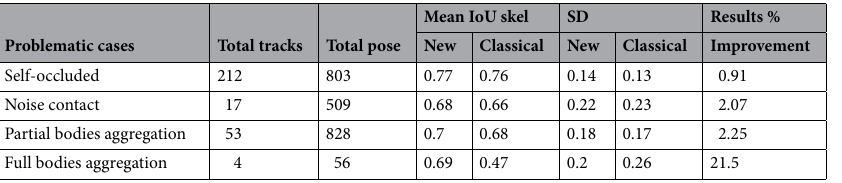
Table 1. Summary of the comparison of automatic methods with the first IoU index. This table includes the results obtained from the validation dataset and the improvements for each case using the first IoU index. The evaluated values show the percentage of success compared to the reconstructed body of the manually labelled skeleton (see the Supplementary Material for more